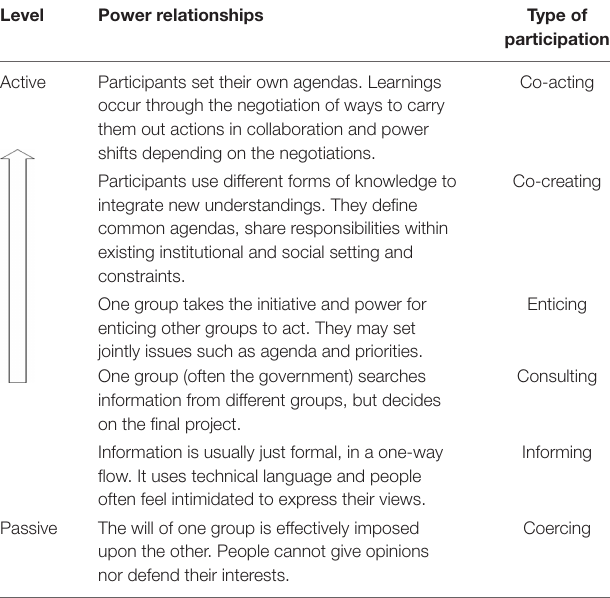
TABLE 1 | Types of